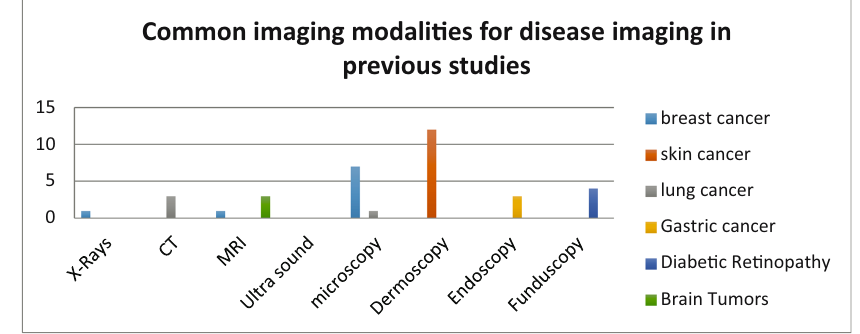
Figure 4: Common imaging modalities for disease imaging in previous studies.